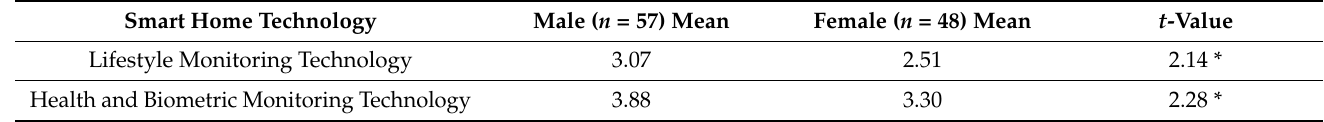
Table 6. Smart Home Technology Preference by